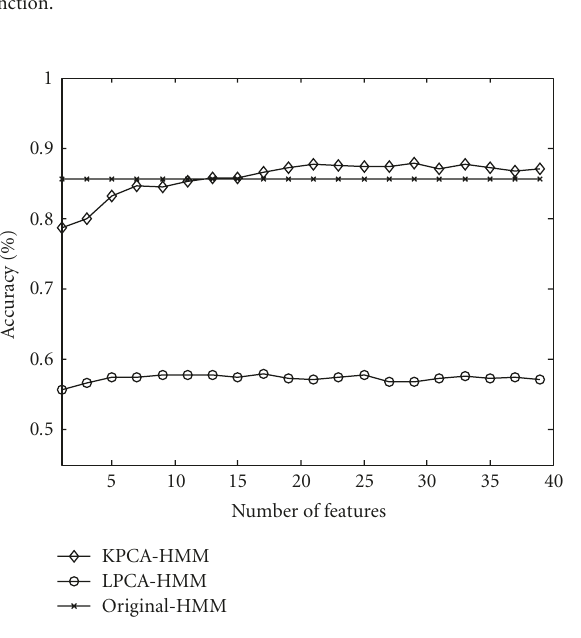
Figure 7: The average classification